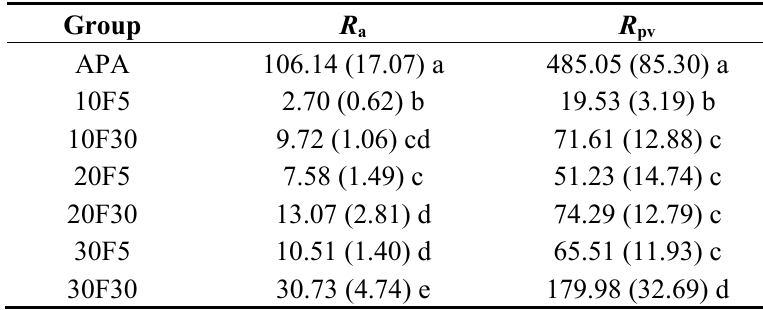
Table 2. Average surface roughness R ceramic specimens (mean (standard deviation) in nm).